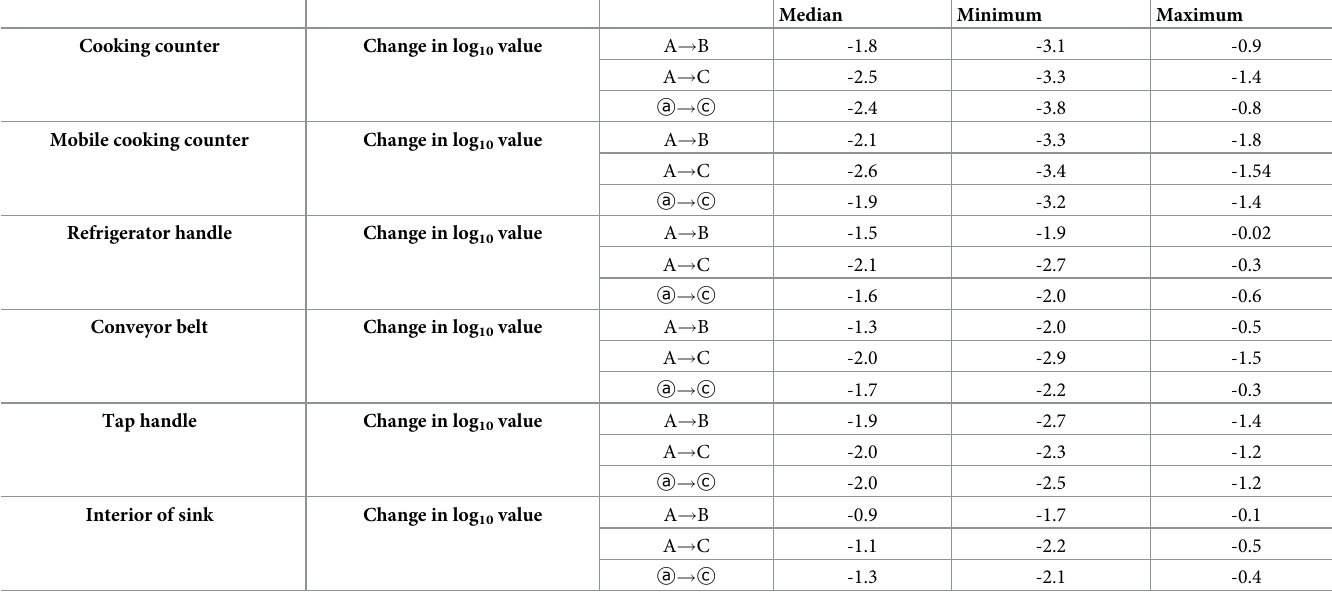
Table 2. Results of the changes in the RLUs (log 10 values) by ATP testing (n =